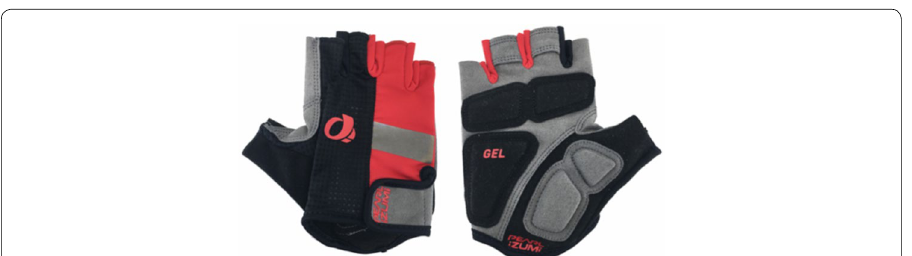
Fig. 8 Historical overview of tactical combat gloves (Echols 2018b)